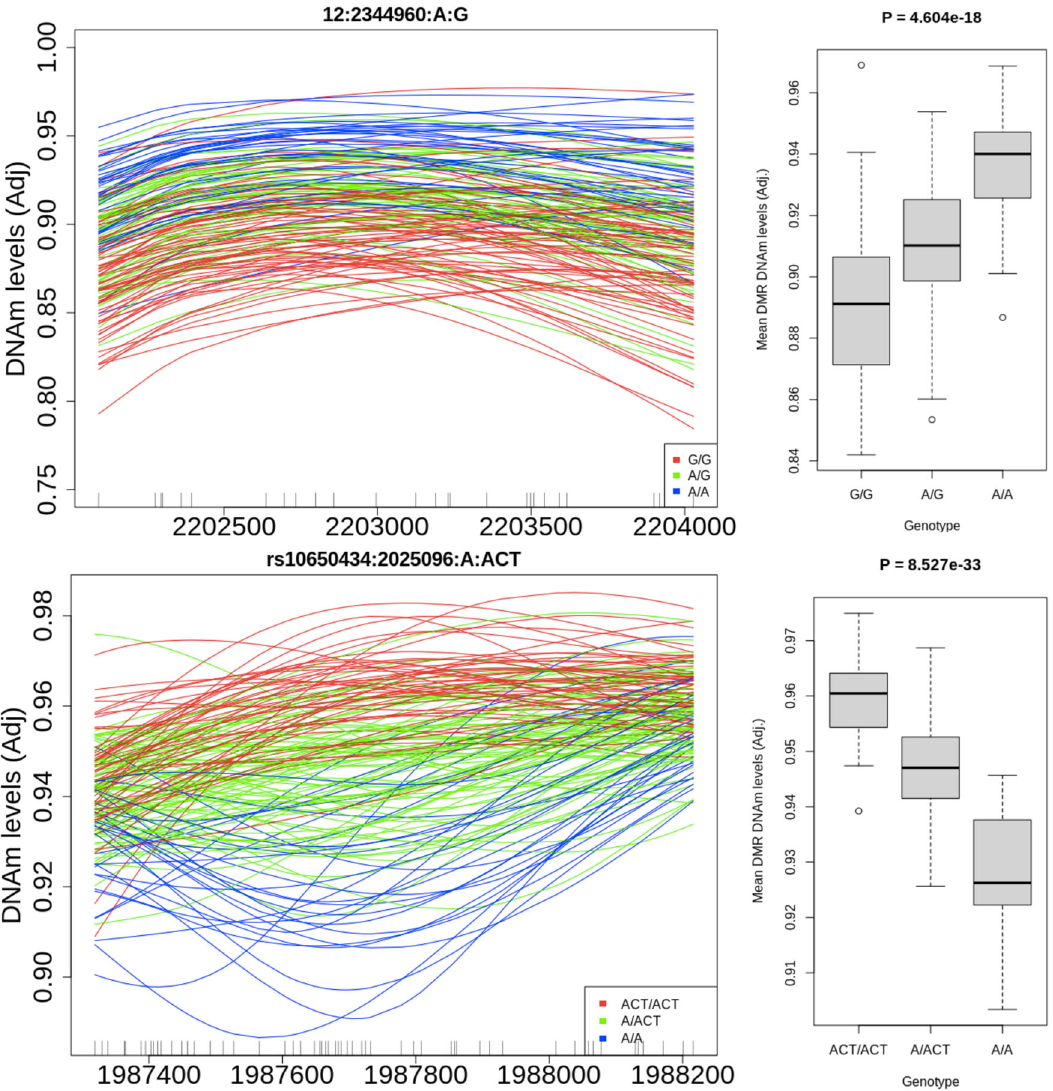
Fig. 3 Schizophrenia risk-associated gDMRs. Two examples of regions where methylation levels are associated with genotype at a schizophrenia risk associated